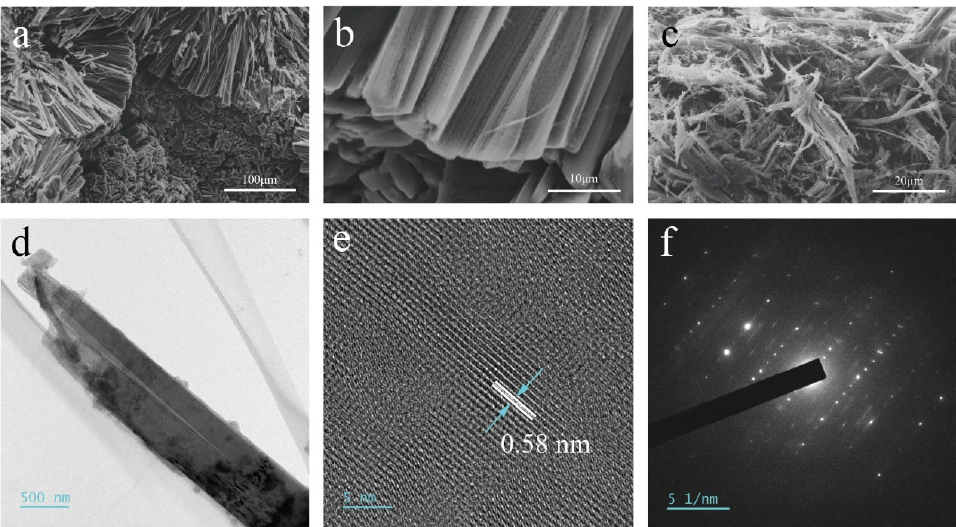
Figure 1. ( a , b ) SEM images of FP bulk; ( c ) SEM image of FP powder; ( d ) TEM image of FP NR; ( e ) HR-TEM image of the FP NR; ( f ) SAED pa tt ern of a single of FP NR. FP was further compared with RP by XRD, as shown in Figure 2a. The XRD pa tt ern of RP is a broad-peaked amorphous phase in the range of 12–18° and 26–36°, correspond- ing to the characteristic peaks of commercial amorphous RP. The XRD peak of FP corre- sponds highly to the XRD di ff raction peak of triclinic P. Also based on the study of Du et al. [23] for FP, it shows that the sample we prepared was 1D FP. In their study of FP, Liu et al. [19] found that FP also has a 2D band structure with a nanoribbon thickness of ap- proximately 7.8 nm, which indicates that FP has not only a 1D structure but also a 2D band structure. As can be seen from the structural diagram of FP (Figure 2a–c), FP consists of P-cage chains of P 8 and P 9 interconnected to form tubular structures, and the layers of